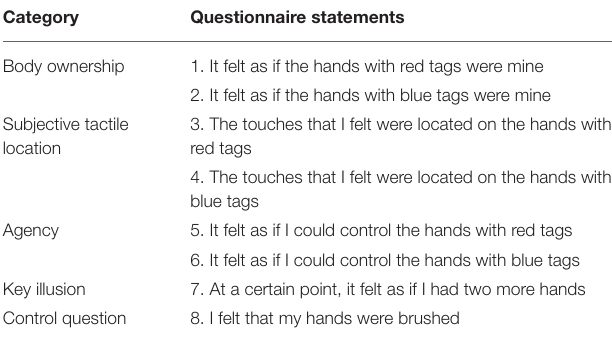
TABLE 1 | Questionnaire